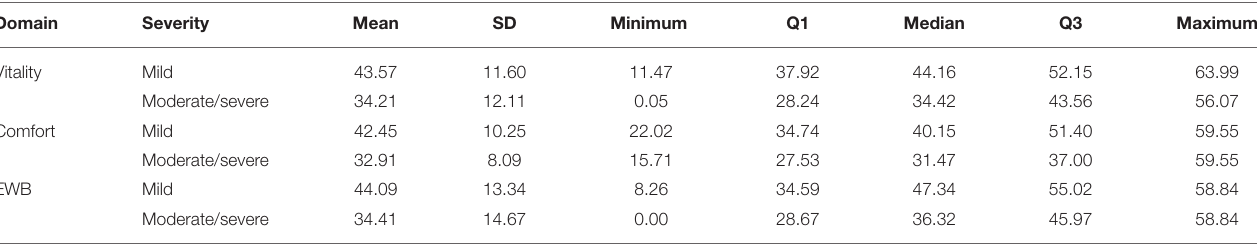
TABLE 2 | Descriptive statistics for three HRQL domains, vitality, comfort and emotional wellbeing (EWB) for mild ( n = 88) and moderate/severe ( n = 52) groups of cats affected by OA. Domain